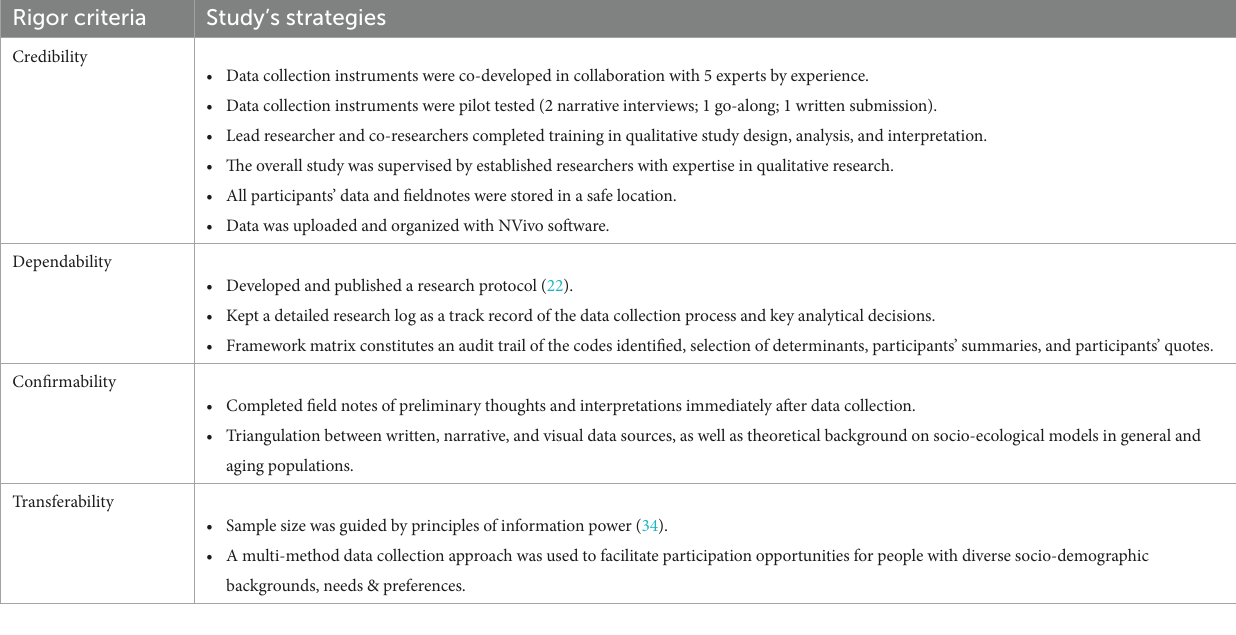
TABLE 1 Strategies adopted to establish methodological rigor according to the FDC